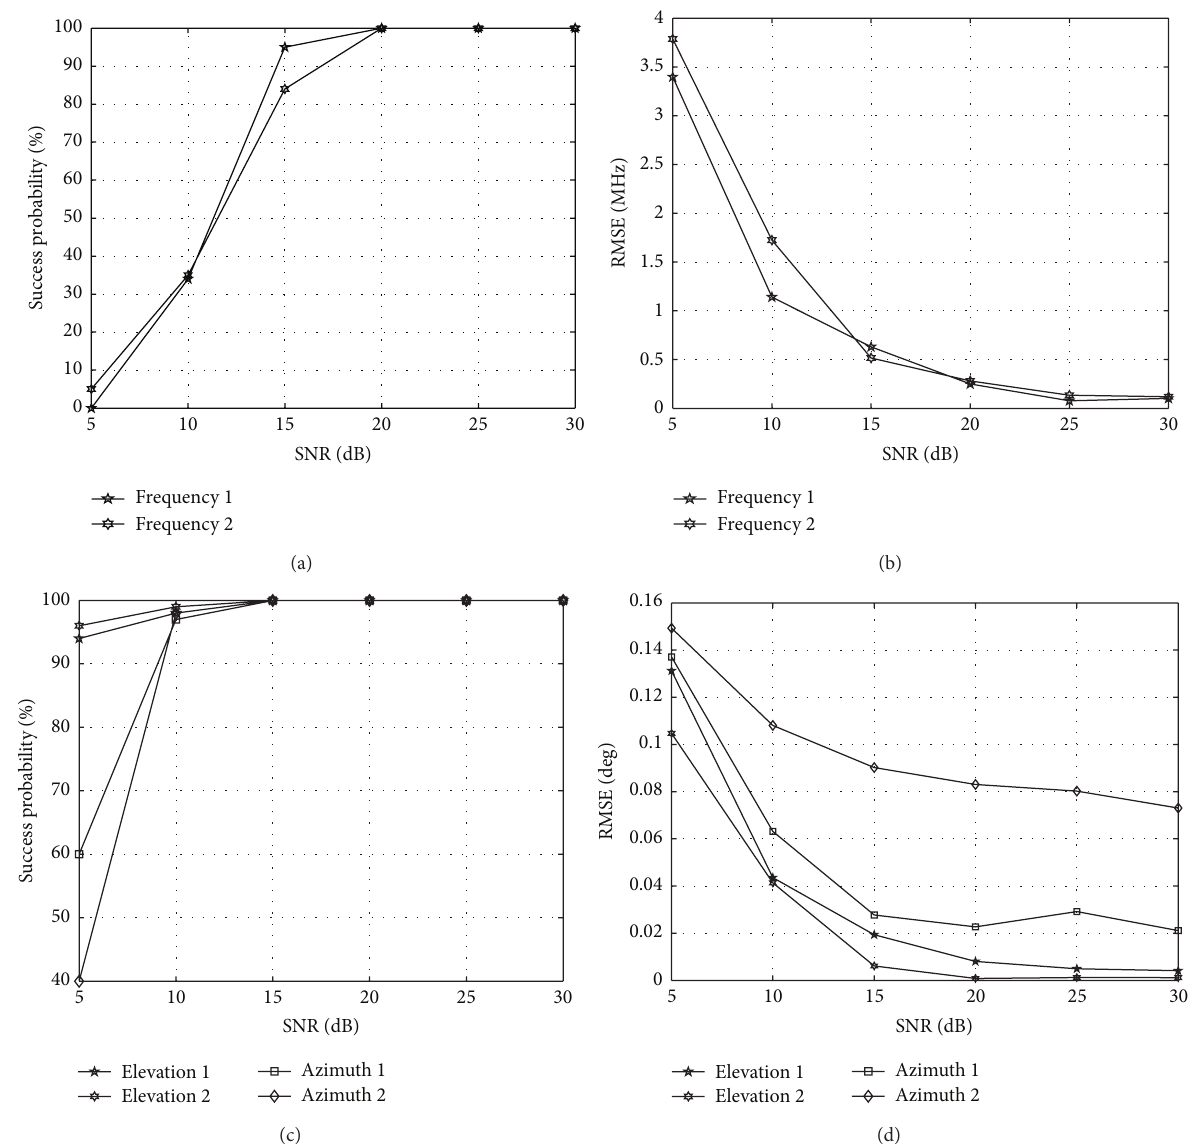
Figure 3: The RMSE and successful probability with different SNR. (a) The successful probability of frequencies, (b) the RMSE of frequency, (c) the successful probability of angles, and (d) the RMSE of